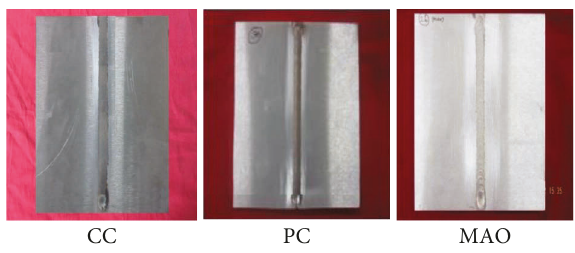
Figure 3: Photographs of MAO joints. Table 2: AZ31B magnesium alloy mechanical properties.